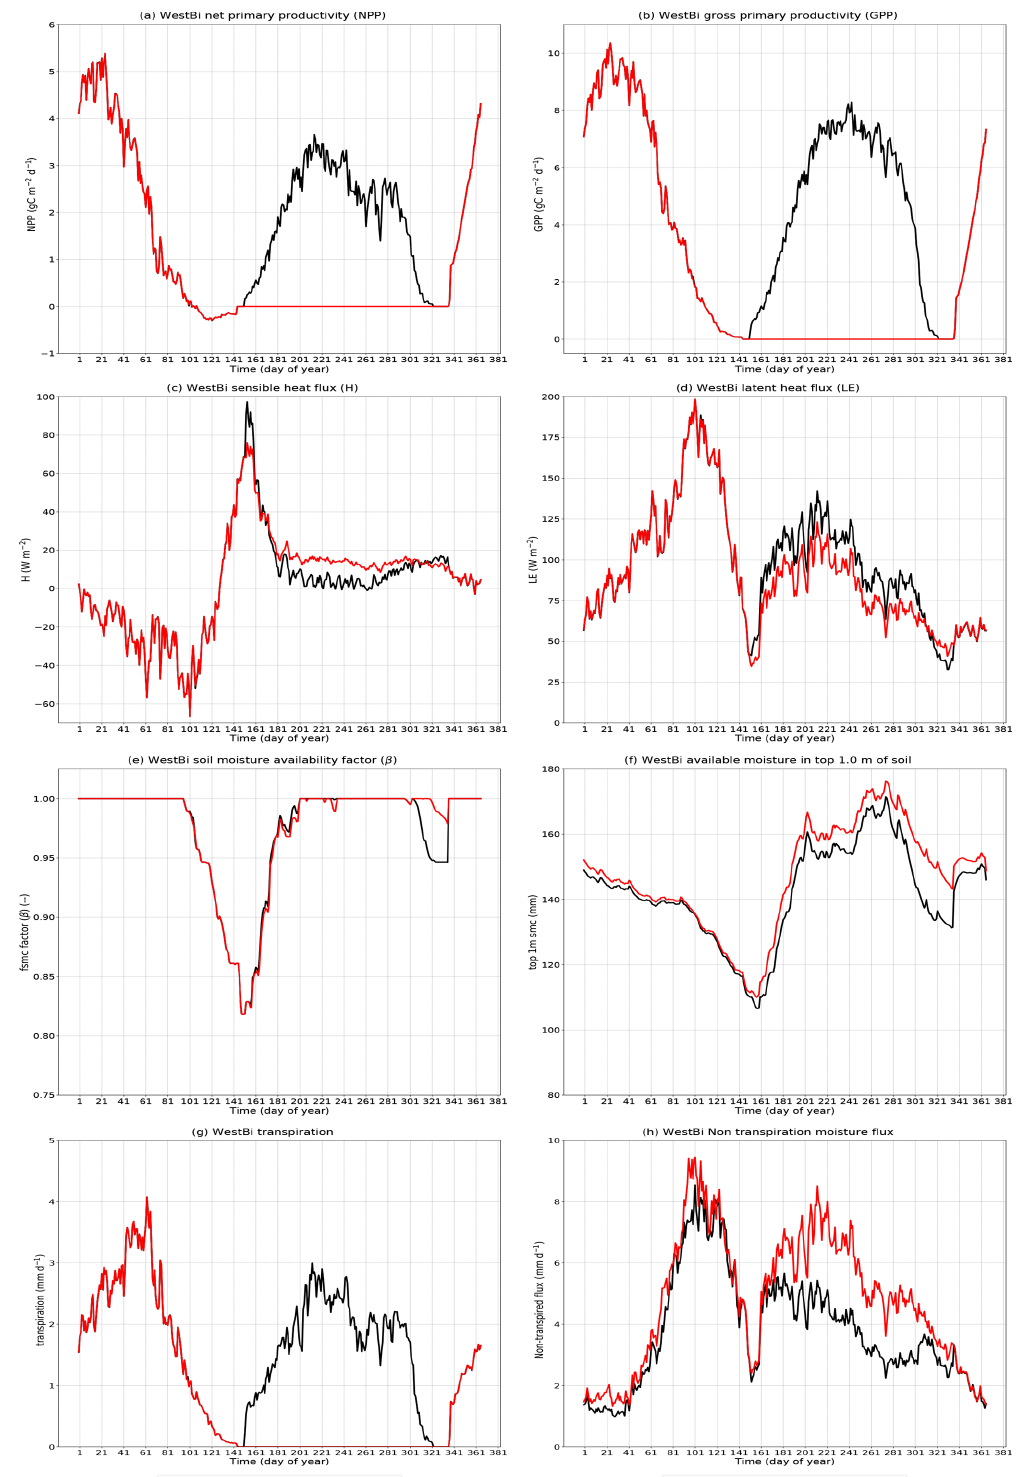
Figure B5. Annual climatology of fluxes (in day of year) for WestBi for India-sequential (black) and India-single (red): carbon fluxes: NPP (a) and GPP (b) . Heat fluxes: sensible heat H (c) and latent heat LE (d) . Soil moisture variables: β (e) and soil moisture availability in the top 1m of soil (f) . Moisture fluxes: evapotranspiration (g) and non-evapotranspiration moisture fluxes (h) .